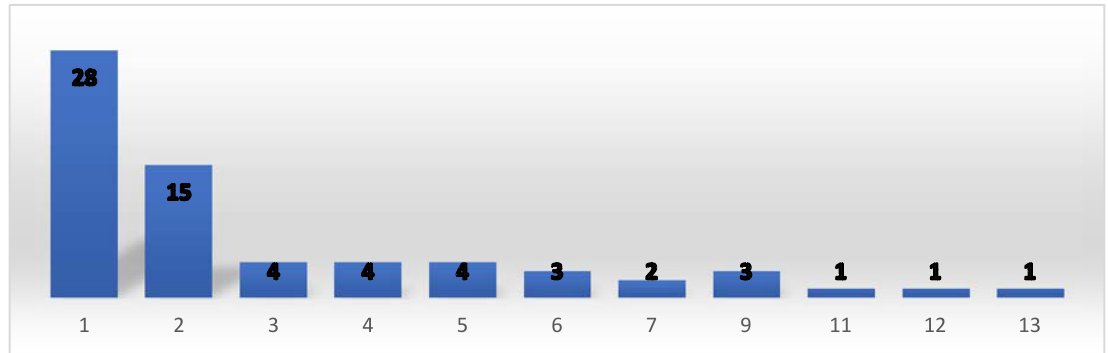
Figure 5. Distribution of Church Camp Attendance (n = 66).